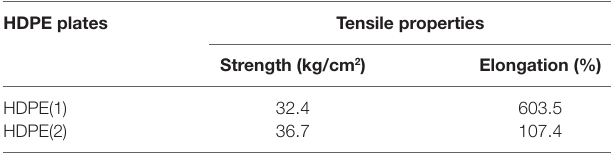
TaBle 1 | Tensile properties of hDPe plates in the machine direction.